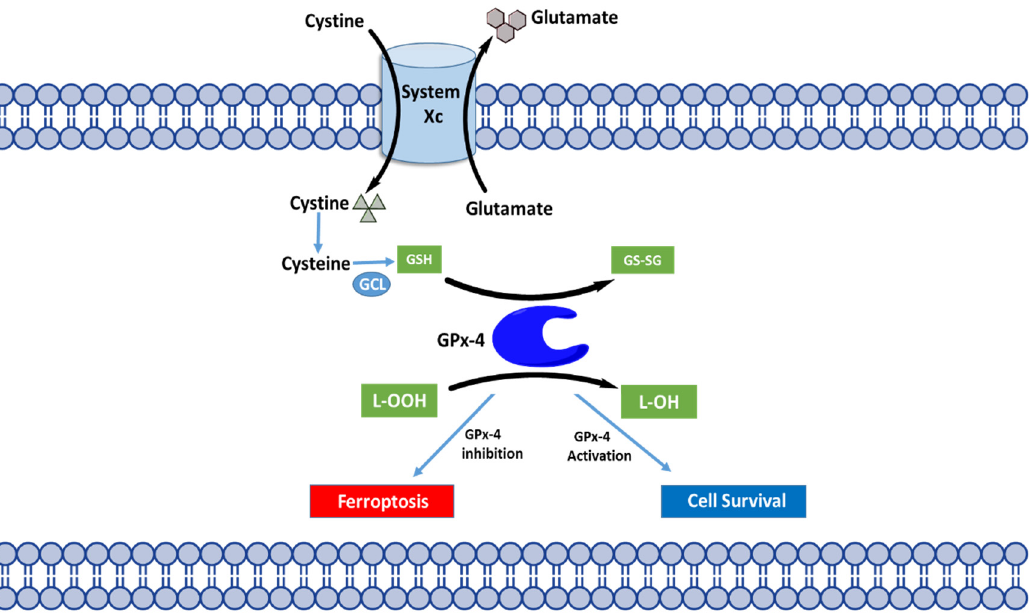
Figure 5. The ferroptotic induced peroxidation of phospholipids is mediated by the Figure cyst(e)ine/GSH/GPX4 regulatory pathway. The system Xc antiporter mediates the exchange of ex- tracellular cystine with intracellular glutamate. When cystine is internalized, it gets reduced to cys- teine which is one of the precursors for the biosynthesis of GSH. GPX4 utilizes GSH as a cofactor for the reduction of toxic lipid peroxides into the respective alcohols. Depletion of either GSH or GPX4 will cause an increase in lipid peroxides that will damage the cell membrane, and lead to ferroptotic cell death—a form of cell death implicated in a wide variety of human diseases.